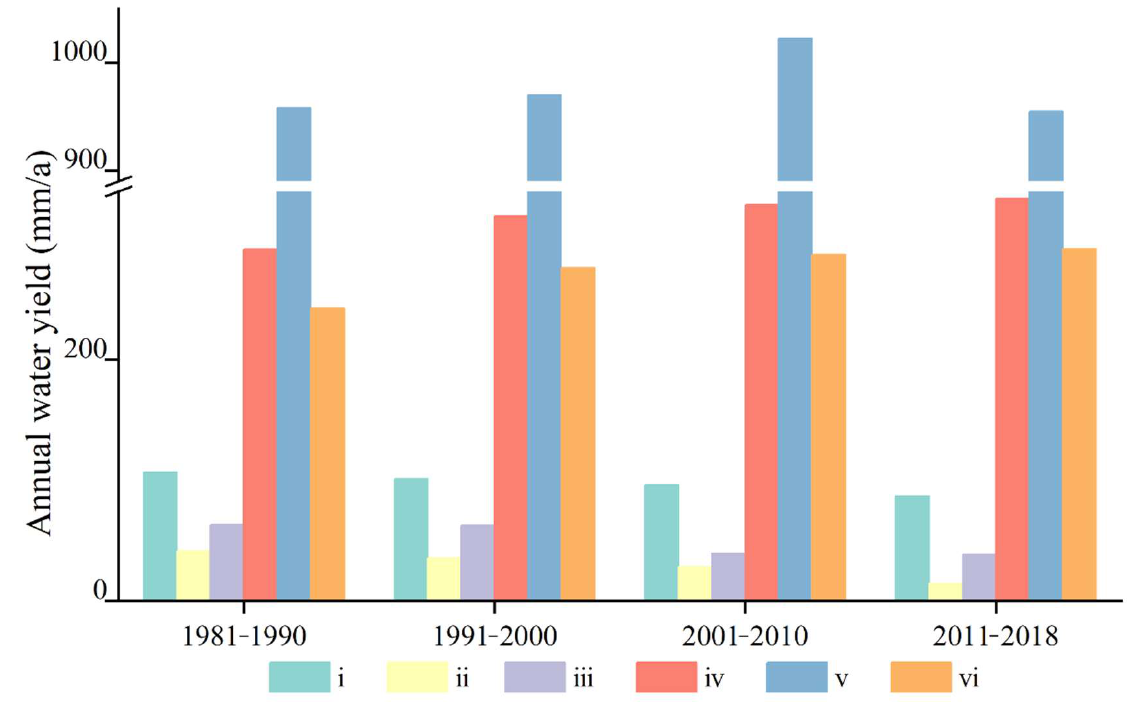
Figure 13. Temporal variabilities of ten-year average terrestrial water yield (WY) from 1981 to 2018 in typical regions (Figure 12). The colored boxes indicate the areas of interest, including parts of Canada ( ⅰ ), Siberia ( ⅱ ), West Asia ( ⅲ ), Australia ( ⅳ ), Central Africa ( ⅴ ), and the Amazon ( ⅵ ). This study had some limitations. First, the land cover change affected the land surface water cycle, ET, and precipitation [64]. In our study, the IGBP for 2001, in the middle of